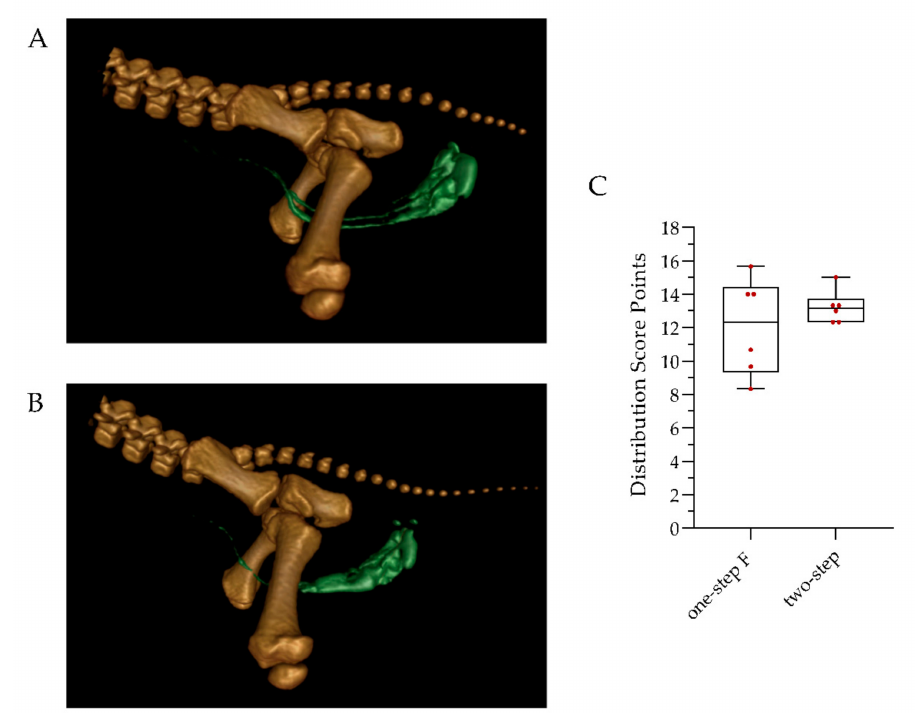
Figure 2. Distribution of the lidocaine/contrast medium mixture directly after injection, using the one-step F and two-step methods. Exemplary three-dimensional reconstruction of a piglet injected with one step F ( A ) and a piglet injected using the two-step method ( B ). Bone structures such as parts of the spine, pelvis and femur are colored brown. The injected lidocaine/contrast agent mixture is colored green. ( C ) CT distribution scoring in piglets injected with the one-step F or two-step